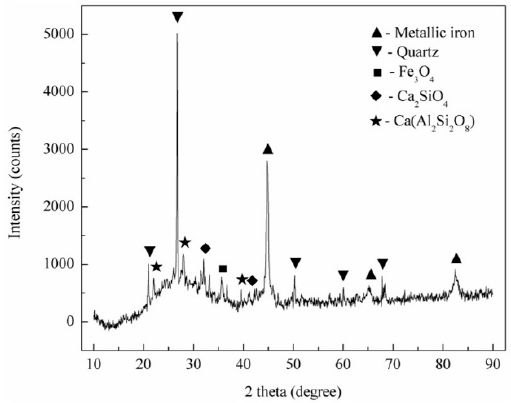
Figure 7. X ‐ ray diffraction pattern of the reduction products. Figure 7. X-ray diffraction pattern of the reduction